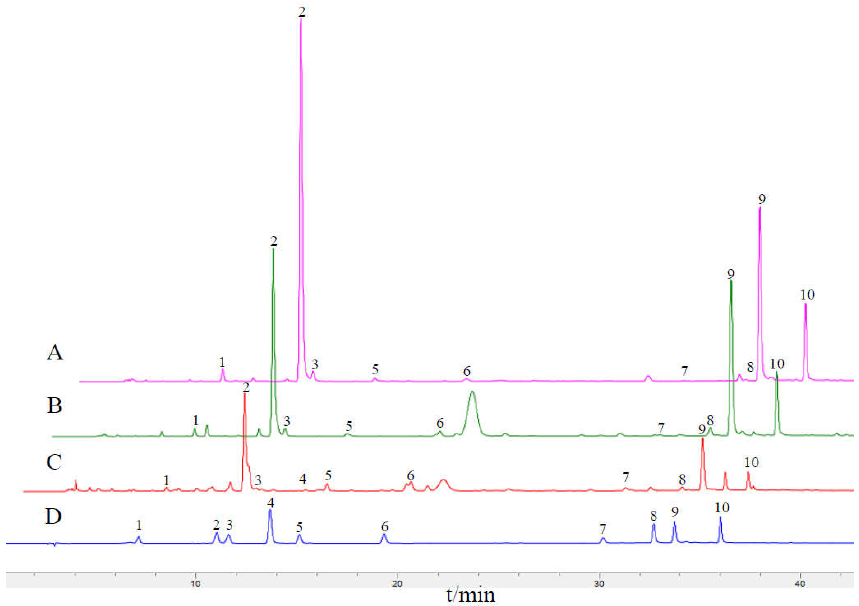
Figure 8. HPLC fingerprints of mixed control and sample. L. similis ( A ), L. acuminata ( B ), L. japonica ( C ), mixed control ( D ). Neochlorogenic acid (1), Chlorogenic acid (2), 4-Dicaffeoylquinic Acid (3), Caffeic acid (4), Sweroside (5), Secoxyloganin (6), Luteoloside (7), Isochlorogenic acid B (8), Isochlorogenic acid A (9), Isochlorogenic acid C (10).